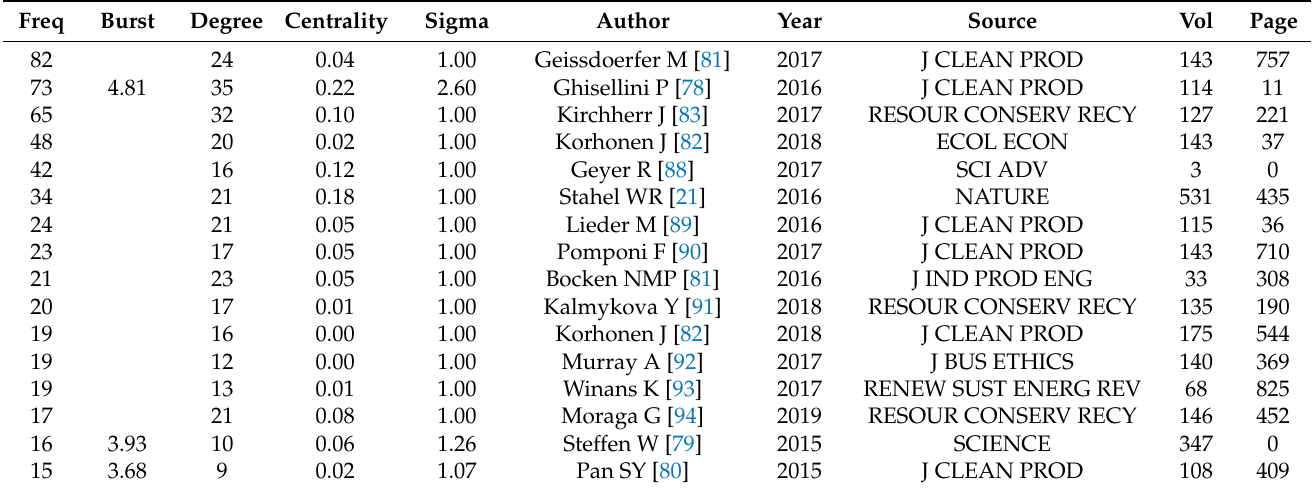
Table 6. Top 16 most cited papers with co-citation